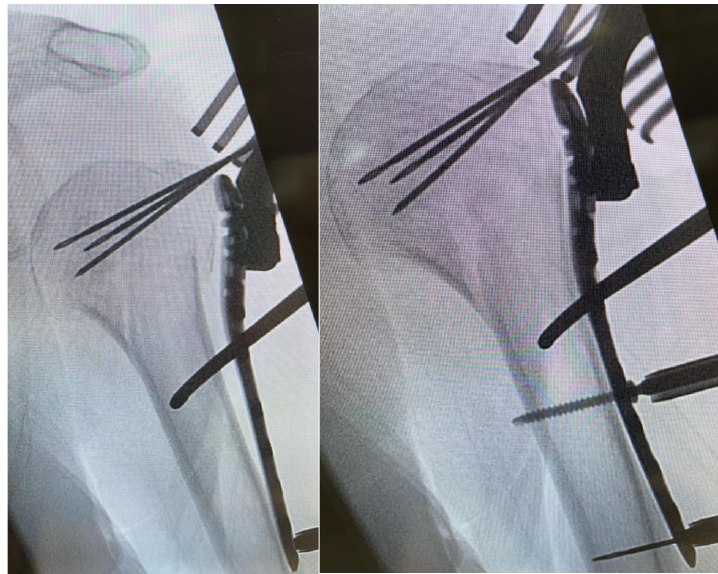
Figure 2. Plate placement, temporary fixation with K-wires and implantation of a cortex screw.